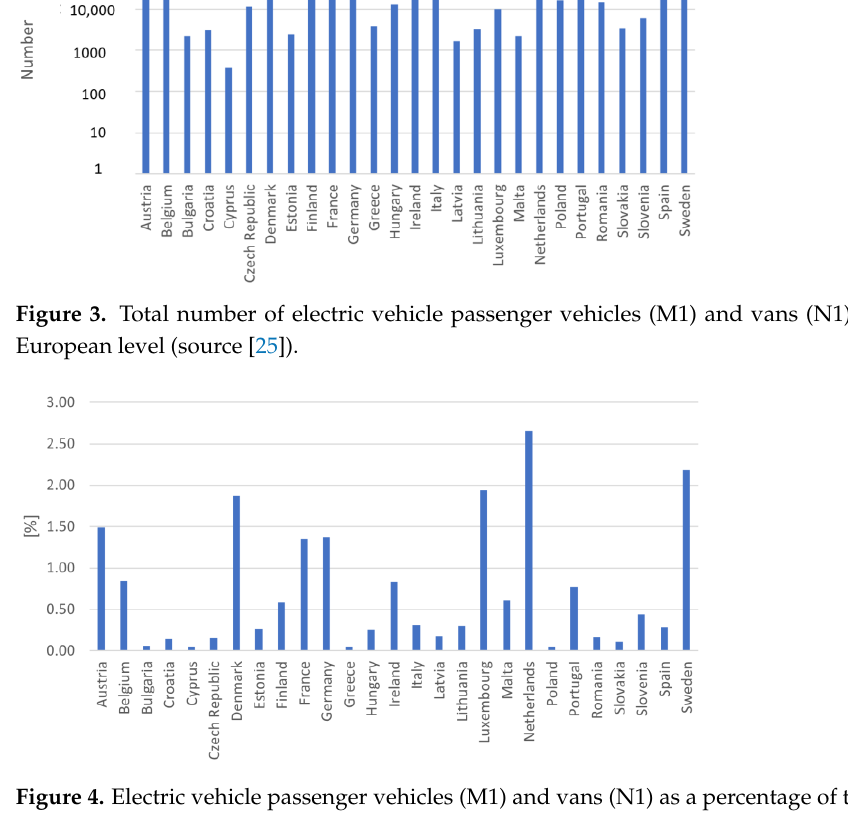
Figure 4. Electric vehicle passenger vehicles (M1) and vans (N1) as a percentage of the total fleet in 2021 at the European level (source [25]).